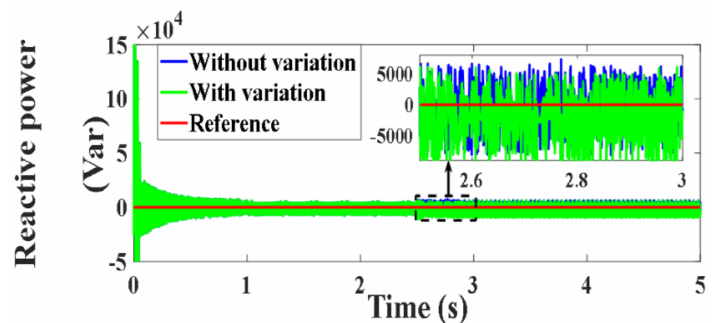
Figure 134. Reactive power under PVC (var).